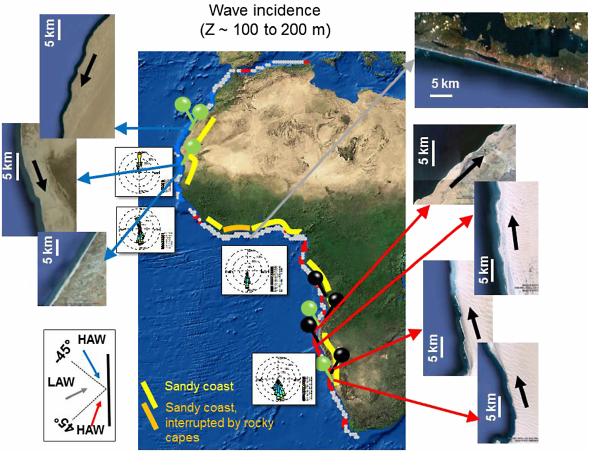
Fig. 4. Wave incidence (2012) and shoreline undulations. Incidence larger than 45 ◦ and smaller than − 45 ◦ are indicated resp. in red and blue on the shoreline, whereas low angle waves are indicated in grey. HAW means High Angle Wave. Green symbols indicate shore- line undulations not identified as such before this study. Black ones indicate already identified shoreline sandwaves. Wave roses illus- trate the wave direction. Satellite images (Google Earth) illustrate the undulated or un-undulated character of the shoreline.